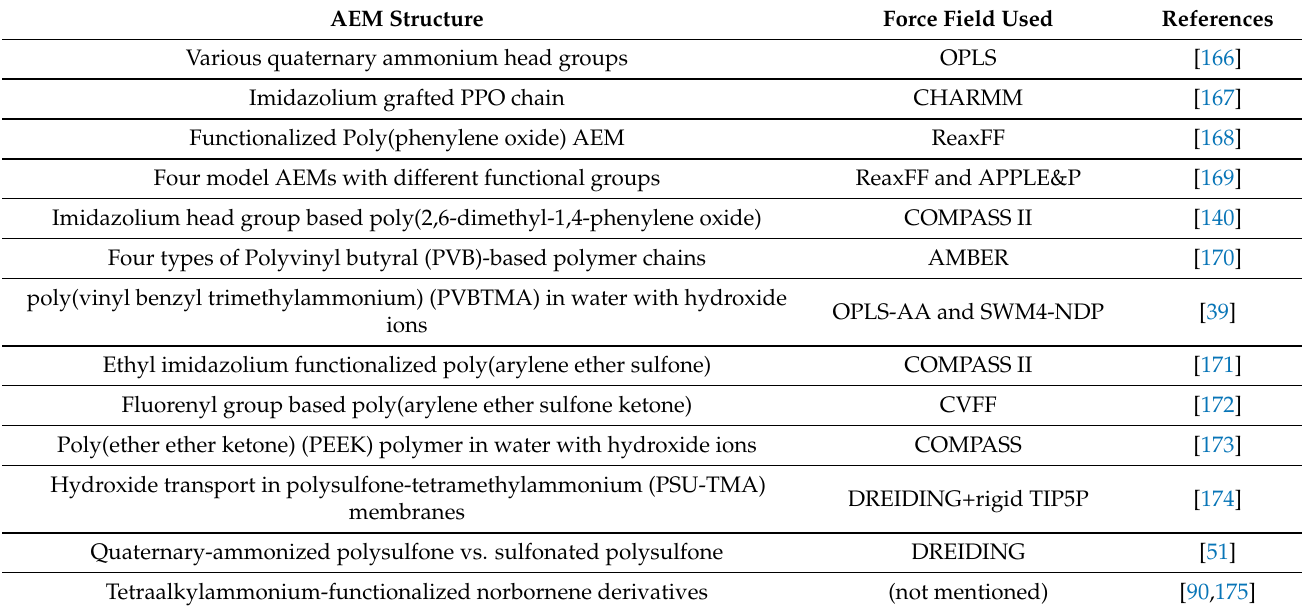
Table 3. Recent all-atom molecular dynamics studies on AEM-related systems AEM